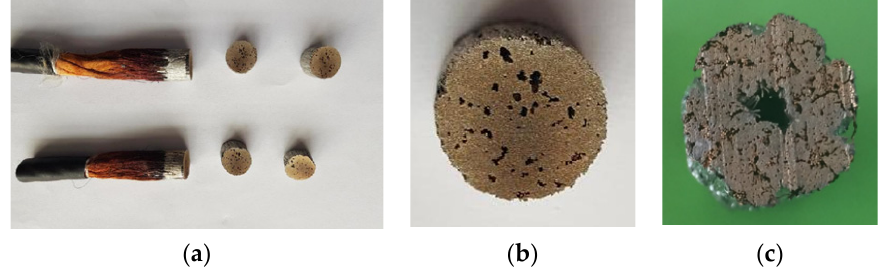
Figure 5. Cross cut of the soldered end. ( a ) Cut of the soldered end. ( b ) Good soldering (3% difference between calculated and measured resistance). ( c ) Bad soldering (27% difference between calculated and measured resistance).